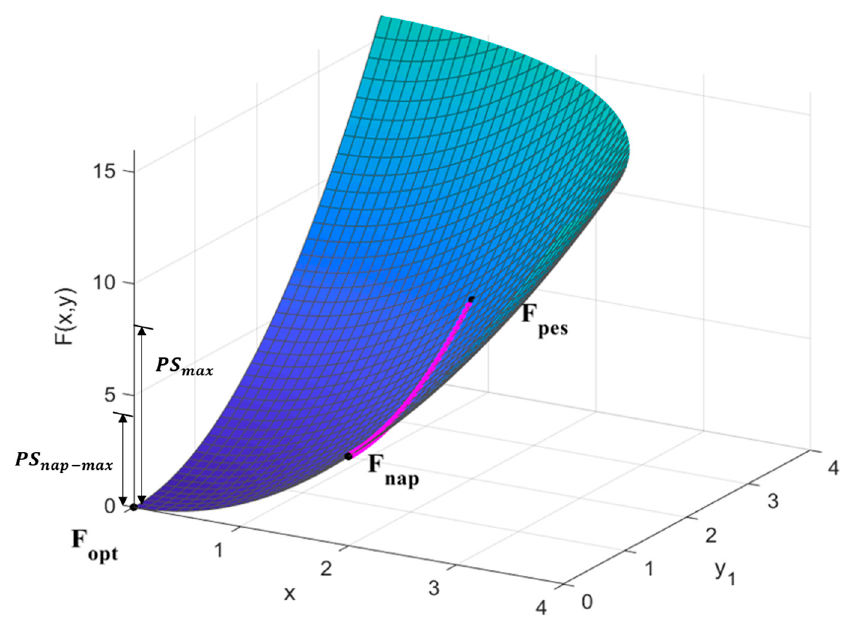
Figure 1. The inducible region IR and IR d of Example 1.